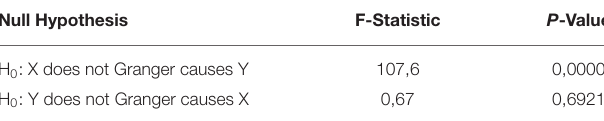
TABLE 5 | Granger causality test.